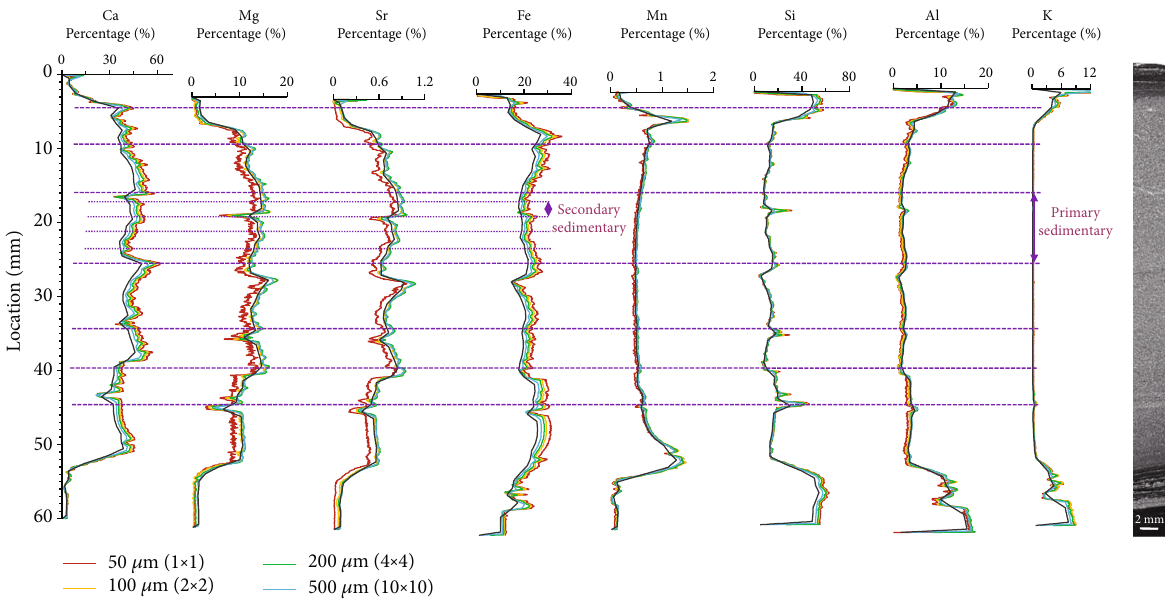
Figure 9: Elemental pro fi les of area B in Figure 1(d) with di ff erent resolutions (50 μ m, 100 μ m, 200 μ m, 500 μ m, and 1000 μ m) after 1 × 1, 2 × 2, 4 × 4, 10 × 10, and20 × 20 points averaged (scanned with 300ms/pixel). The intervals divided by purple dashed lines represent primary and secondary sedimentary cyclicities with a length of 7.8-9.5mm and 1-2.5mm,